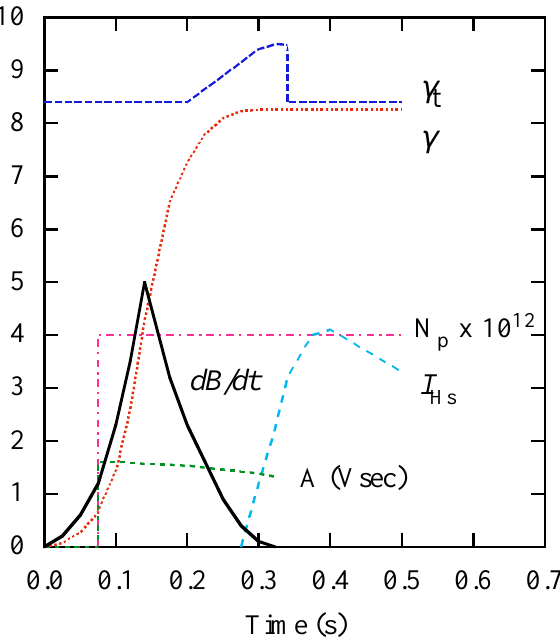
FIG. 3. (Color) The operating mode of the AGS, showing the magnet ramp (cid:100)(cid:66) (cid:121) (cid:100)(cid:116) , beam gamma g , transition gamma g (cid:116) , sextupole currents (cid:73) (cid:72)(cid:115) , and longitudinal bunch area A. (cid:49)(cid:46)(cid:53) 6 (cid:48)(cid:46)(cid:48)(cid:53) eV s, declining during the cycle. Measure- ments of the bunch area were made by reconstructing the bunch shape by observing the development of the time profile during synchrotron rotations: The data are shown as a function of time from injection in Fig. 4.